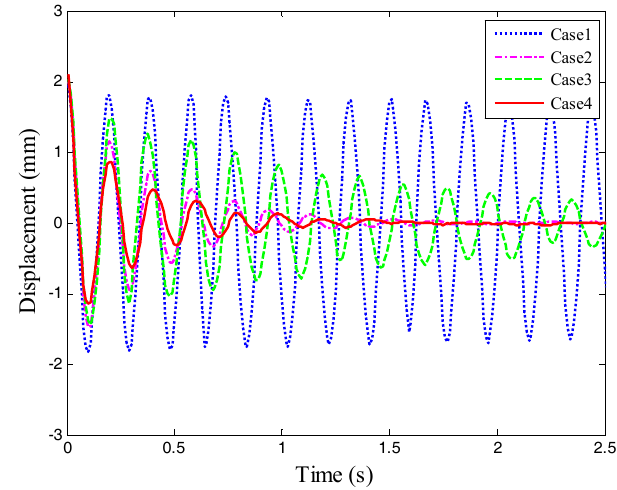
Figure 3. Free vibration response of cantilever beam in each case.